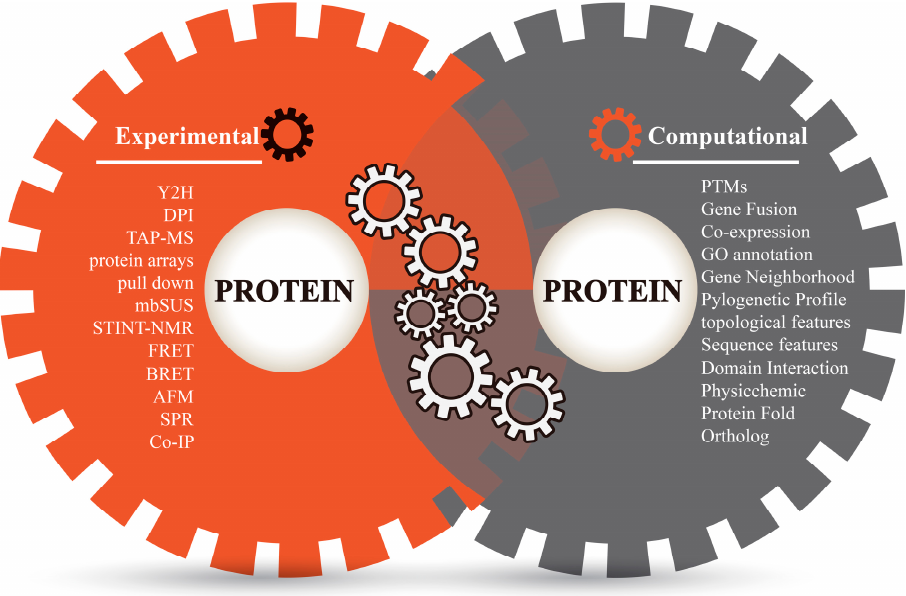
Figure 1. Different methods for detecting protein − protein interactions.